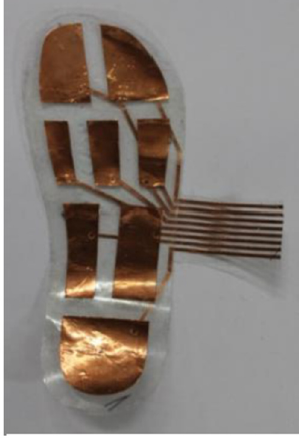
Figure 2. Cut-out of sensor areas using Vinyl Cutter.